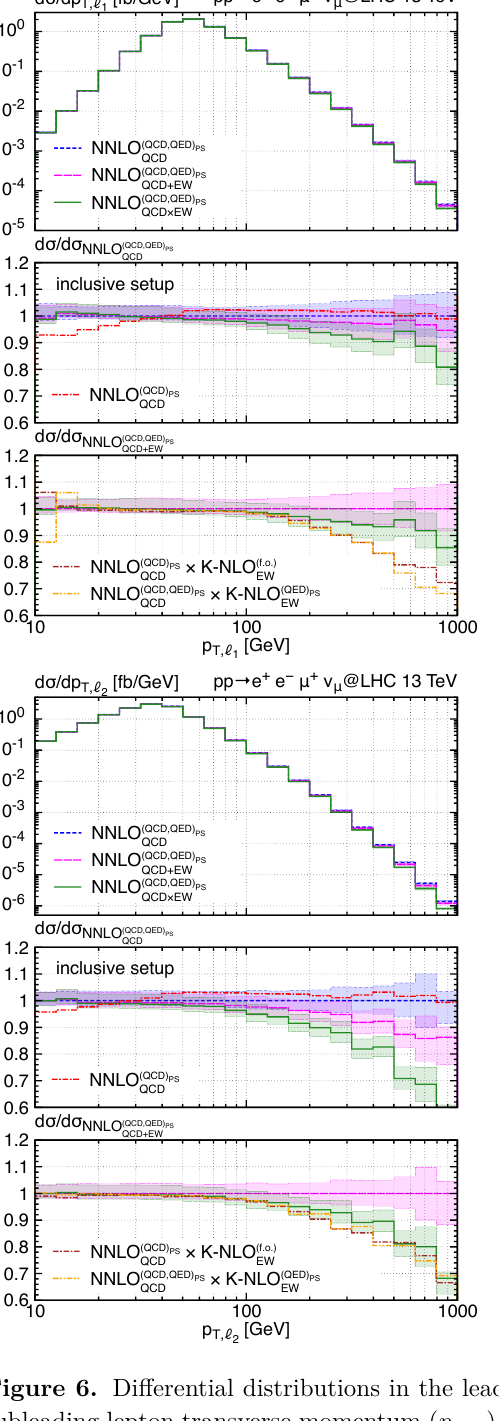
) in W + Z production in the inclusive setup (left) T, ‘ 2